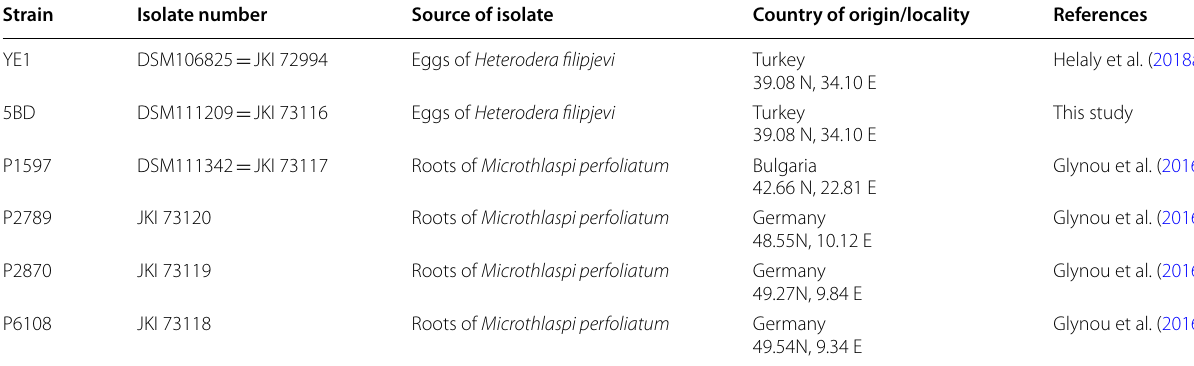
DSM: The open collection of the Leibniz-Institut DSMZ- German Collection of Microorganisms and Cell Cultures GmbH; JKI: Julius Kühn Institute culture collection, Mykothek